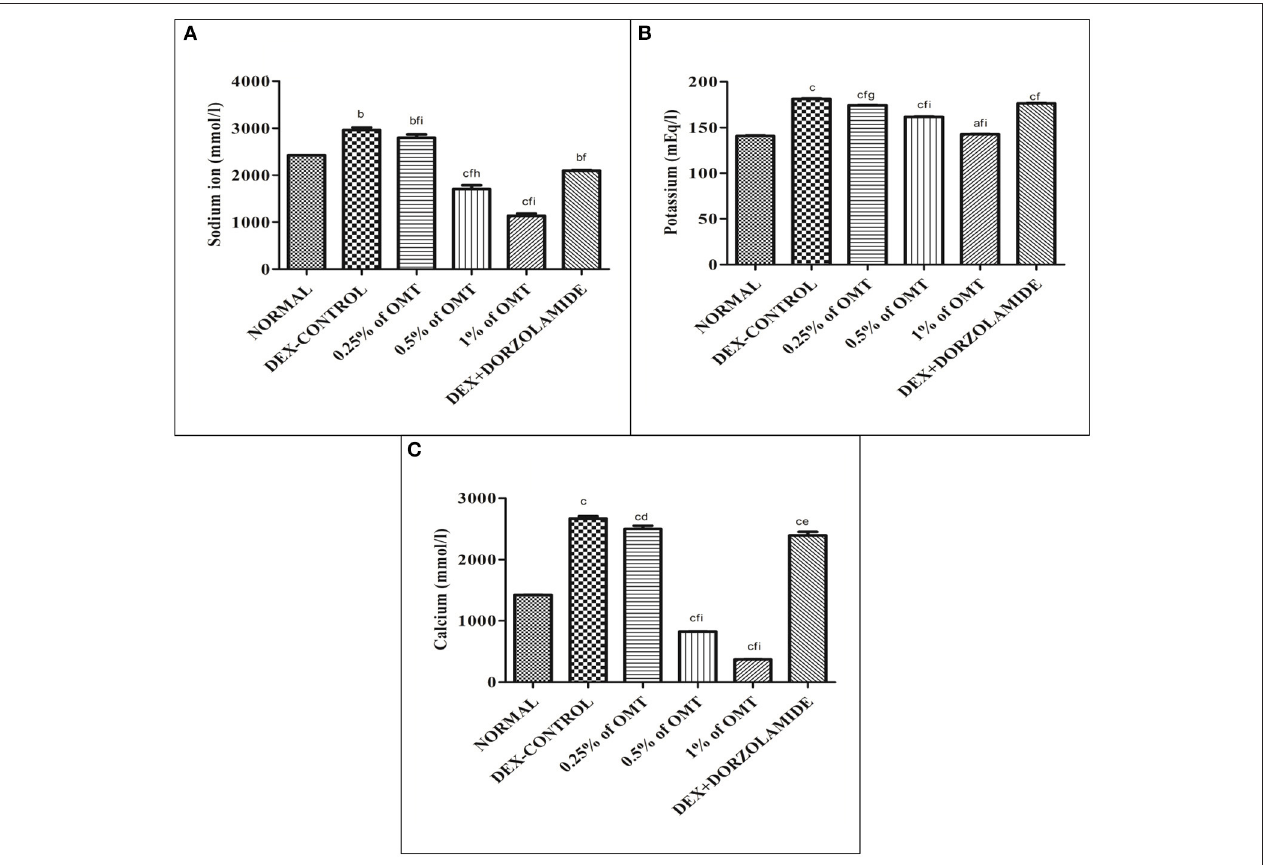
FIGURE 6 | Effects of various treatments on (A) Na + , (B) K + , (C) Ca + 2 ion activities in the retinal extracts. Values are expressed as mean ± SEM ( n = 6). Data were analyzed by one-way ANOVA and are expressed as a p < 0.05, b p < 0.01, c p < 0.001 when compared to normal group, d p < 0.05, e p < 0.01, f p < 0.001 when compared to DEX-induced glaucoma control group, and g p < 0.05, h p < 0.01, i p < 0.001 when compared to standard group, respectively. Normal: 100 µ l of distilled water; control: 0.1ml of 0.1% DEX solution; treatment 1: 50 µ l of 0.25% OMT solution; treatment 2: 50 µ l of 0.5% OMT solution; treatment 3: 50 µ l of 1% OMT solution; standard: 100 µ l of 1% of dorzolamide